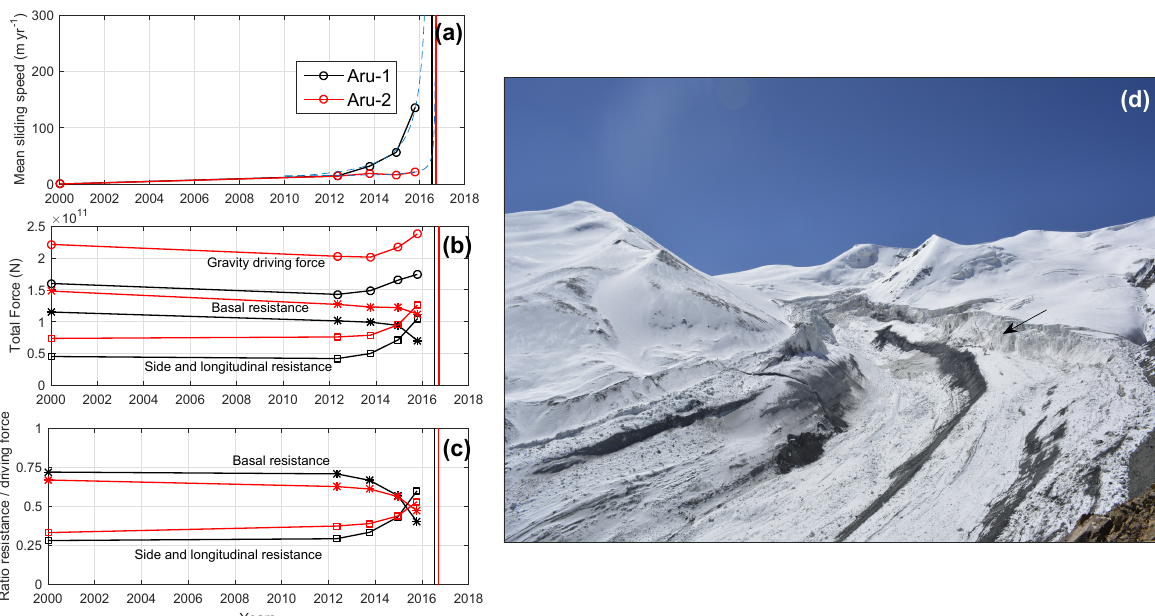
Figure 9. (a) Mean sliding speed of the detachment zone for Aru-1 (black) and Aru-2 (red) glaciers. The dashed blue lines show predicted speed following an empirical law of slope failure (Voight, 1990). (b) Force balance acting on the detachment of Aru-1 (black) and Aru-2 (red). (c) Ratio of resisting force over driving force for Aru-1 (black) and Aru-2 (red). Vertical lines show collapse dates in the three panels. (d) The Aru-2 glacier detachment zone on 4 October 2016 (Picture from T. Yao). The side resistance computed in the force balance analysis arises from lateral shearing on the right side of the detachment (black